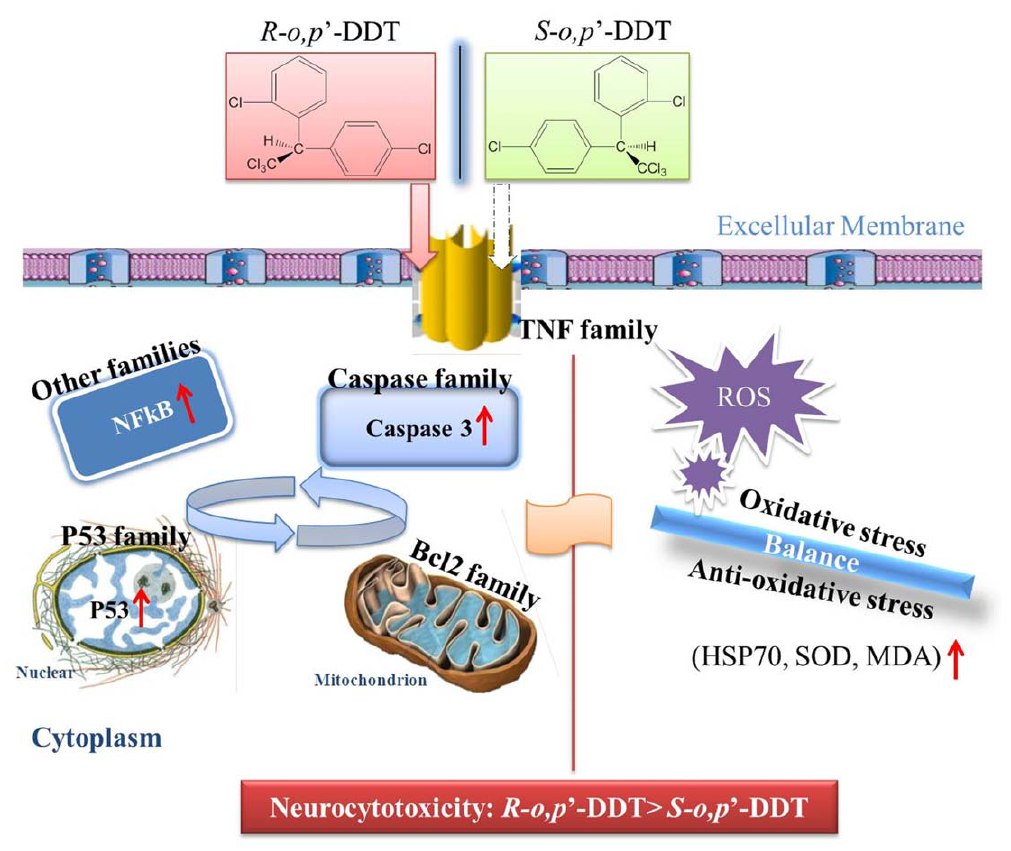
Figure 6. A speculated signaling pathway mediated by o,p ’-DDT for the induction of cells apoptosis. The red arrowheads indicate the more significant upregulation of apoptosis-related molecules induced by R -form than that of S -form. Reactive oxygen species (ROS), Heat shock proteins (HSPs), Lactate dehydrogenase (LDH), Superoxide dismultase (SOD), Malondialdehyde (MDA).